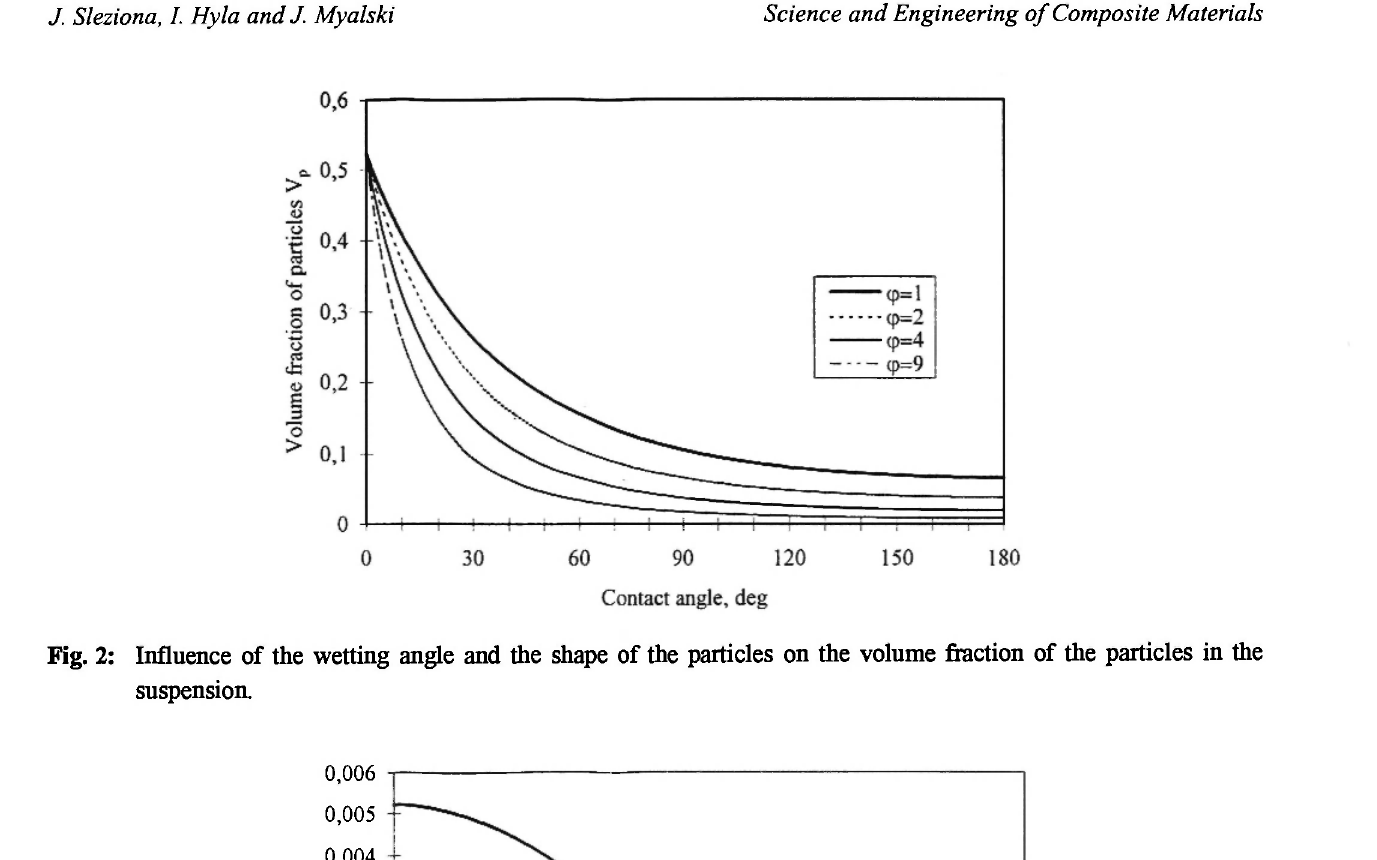
Fig. 3: Influence of the wetting angle on the velocity of the ceramic particle in the liquid aluminium. wetting phenomenon. To confirm this hypothesis, the model of a particle in liquid metal at a depth h has been examined. The forces resulting from the metallostatic and medium lift (connected with wetting) and the flow resistance have an influence on the particle in the liquid. The equation of the particle motion in the liquid has the form: